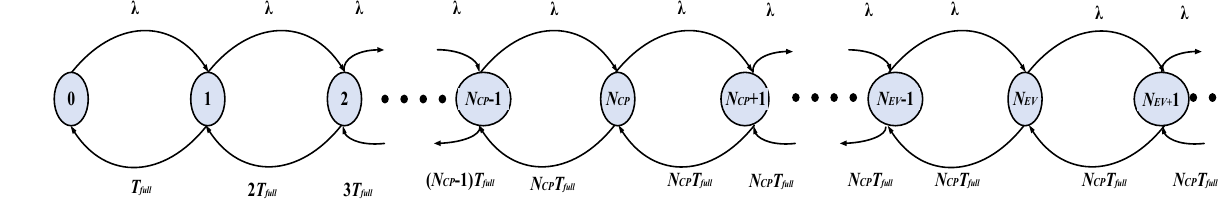
Figure 2. Transition rate diagram.